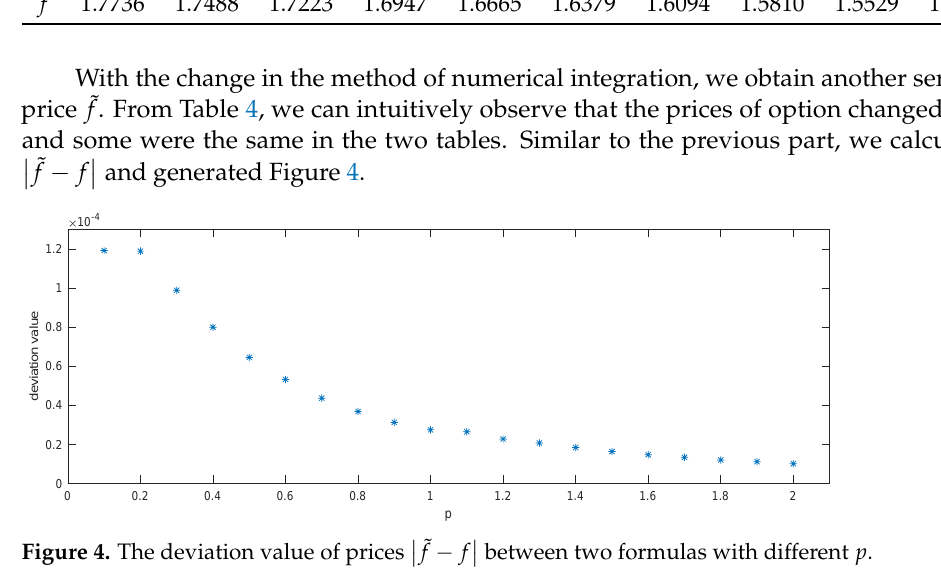
Figure 4. The deviation value of prices